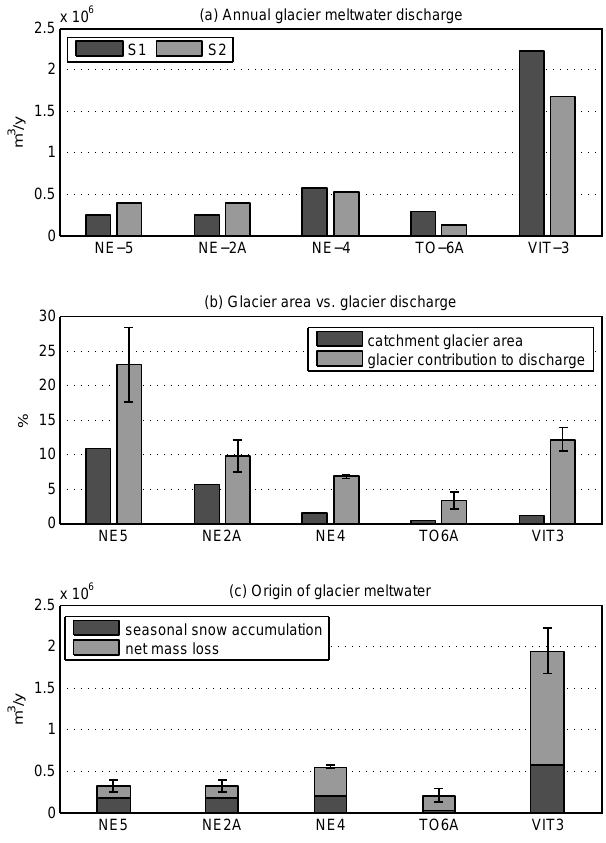
Fig. 7. Mean annual glacier contribution to streamflow per catch- ment over hydrological years 2003/2004–2007/2008. (a) Absolute contribution for each sublimation estimations, (b) relative contribu- tion compared with catchment glaciated fraction, (c) contribution of annual accumulation and net mass loss to glacier melt. Each error bar is associated with the total glacier melt